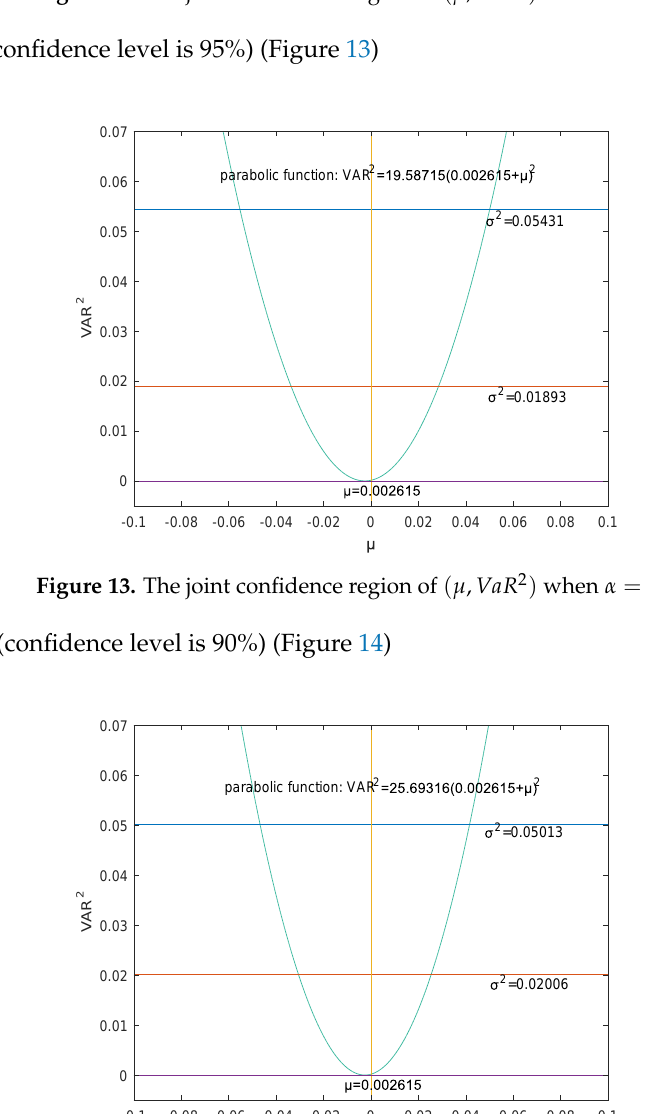
Figure 12. The joint confidence region of ( µ , VaR 2 ) when α = 1%.